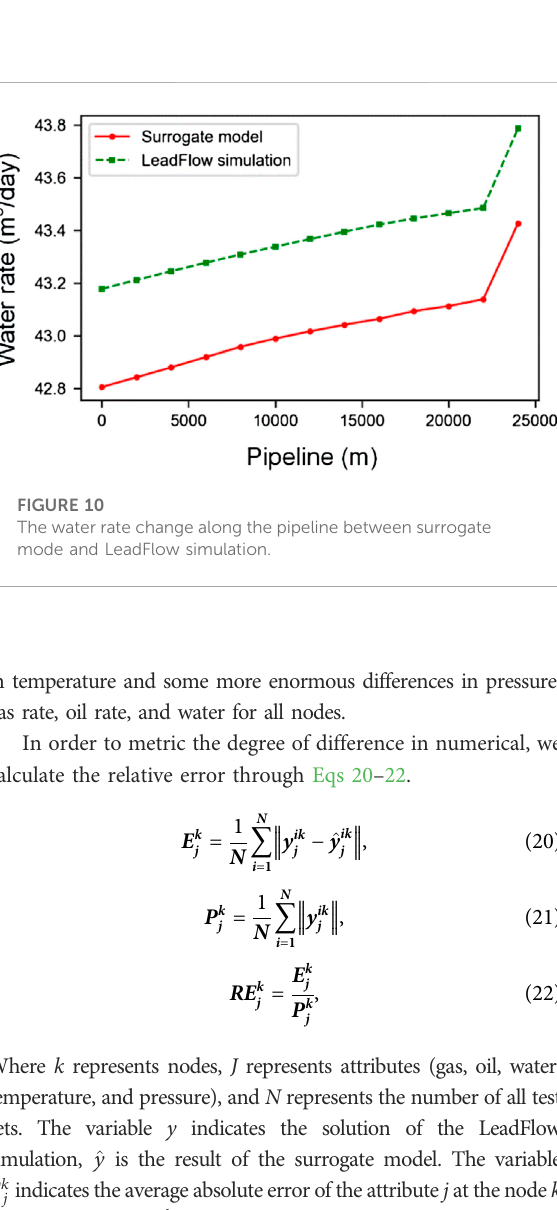
median error; the bottom and top edges of the box represent the 25th and 75th percentile errors; the “ whiskers ” protruding from the box represents the minimum and maximum errors. Though the oil